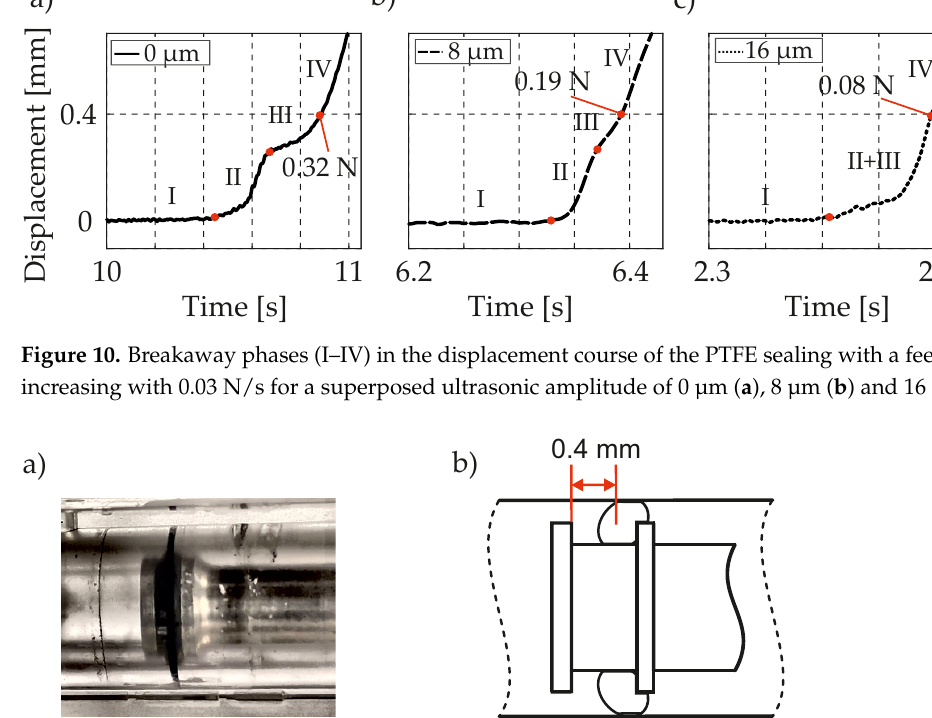
Figure 11. ( a ) Validation of the assumed movement of the seal with a transparent glass housing. ( b ) Schematic of movement and elongation of the seal at the breakaway point in the